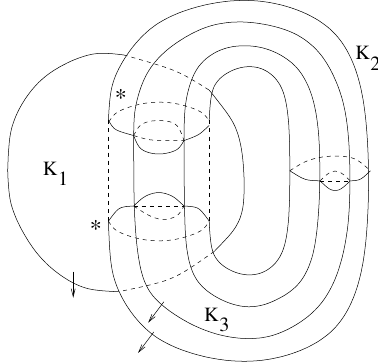
Figure 7 . An example of a non-trivial triple linking number between surfaces K 1 ; K 2 ; K 3 . The (cid:12)gure is taken from